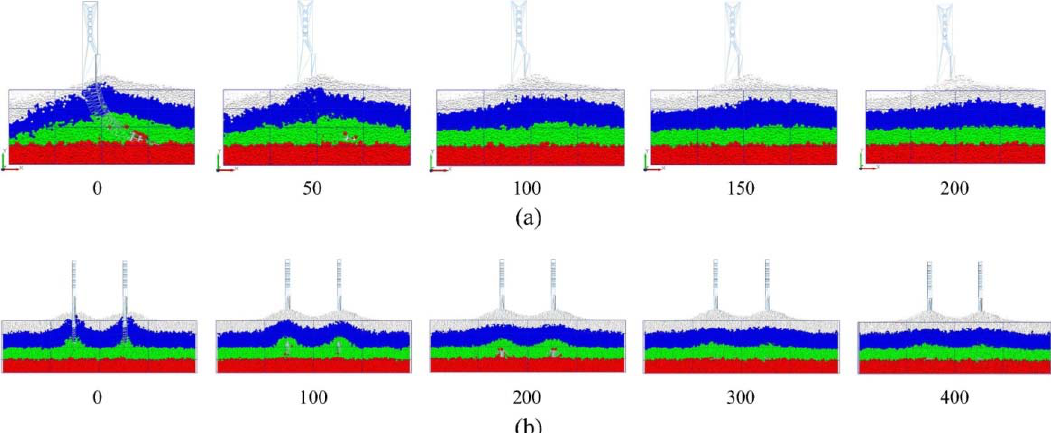
Figure 6. Analysis of the soil disturbance process (Hang et al., 2017): ( a ) Schematic diagram of the disturbance process in the longitudinal-sectional; ( b ) Schematic diagram of the disturbance process in the transverse-sectional.